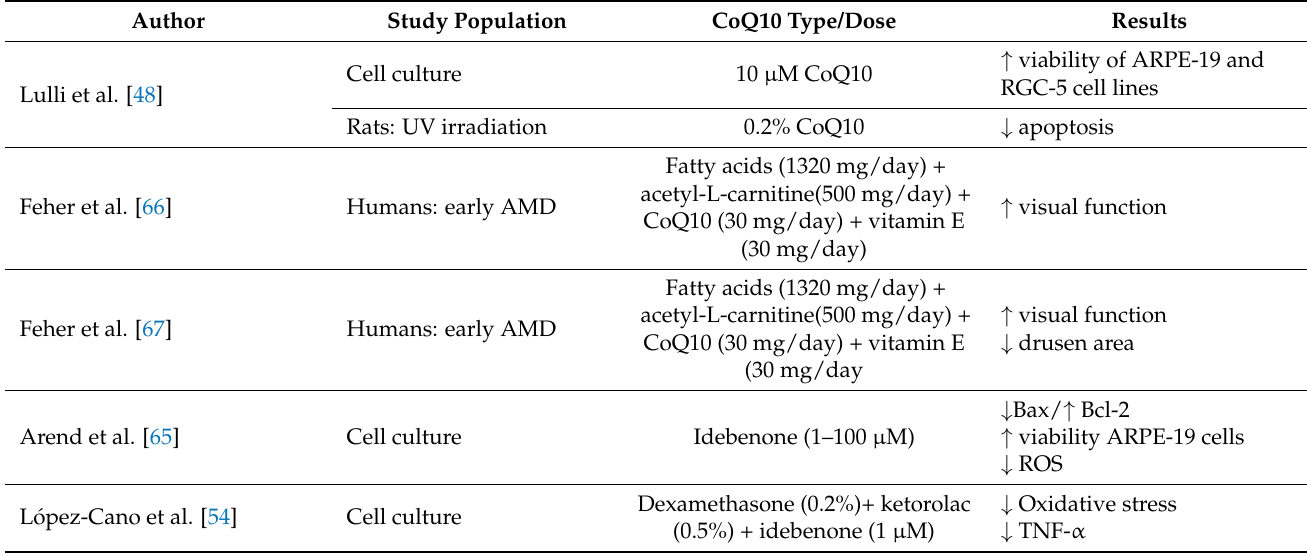
Table 4. Summary of articles that relate CoQ10 to